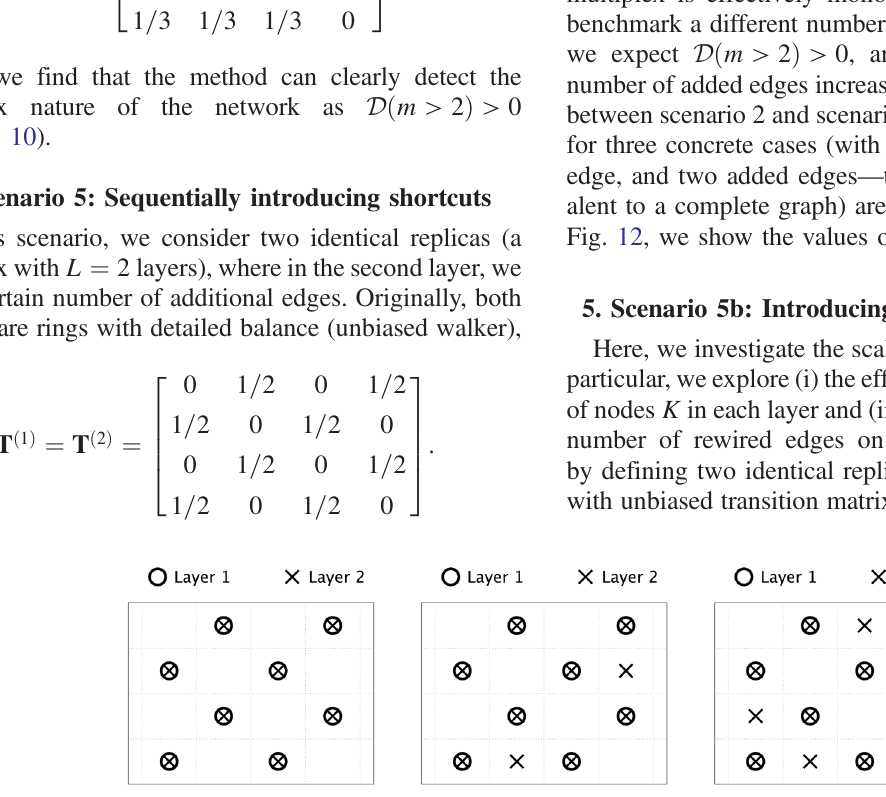
FIG. 11. Scenario 5. Adjacency matrices of each layer for three cases: (i, left panel) No shortcuts are introduced, and both layers are identical; (ii, middle panel) one shortcut has been introduced; (iii, right panel) two shortcuts have been rewired. The transition matrices A =k for each case are T , where k is the degree of node i . ij ¼ ij i i